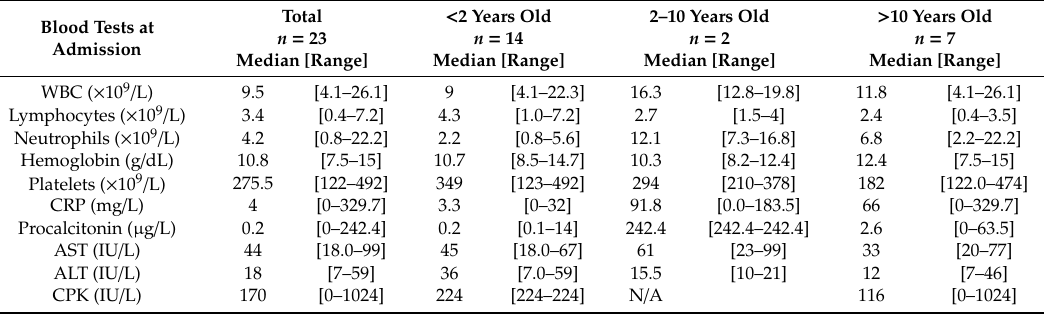
Table 2. Blood tests at admission for the 23 children with SARS-CoV-2